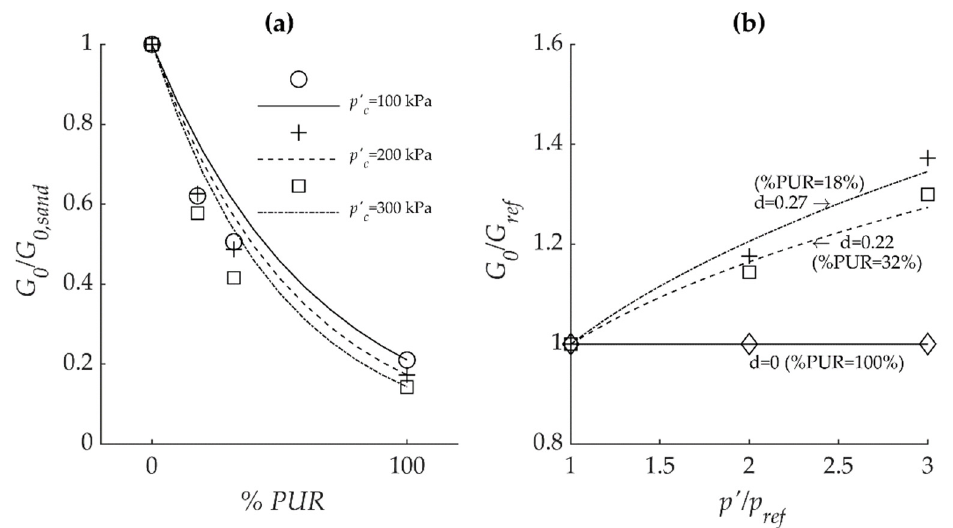
Figure 7. Homogenisation procedure of the small-strain parameters for the composite specimens. ( a ) Experimental (points) vs. analytical (lines) G 0 /G 0,sand varying with the polyurethane volumetric percentage. ( b ) Calibration of d exponent for shear modulus variation with the isotropic stress.